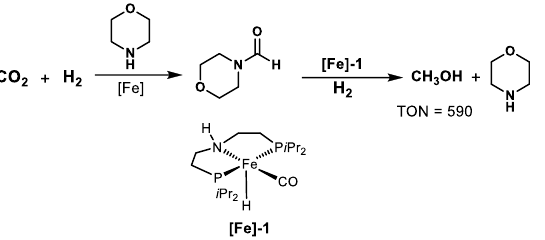
Figure 17. Iron complexes catalyzed hydrogenation of CO 2 .